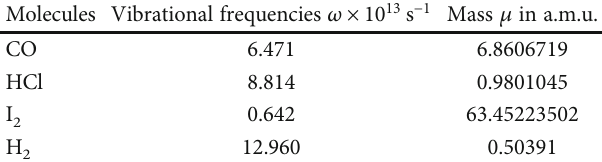
Table 1: Molecular parameters for this study [21].